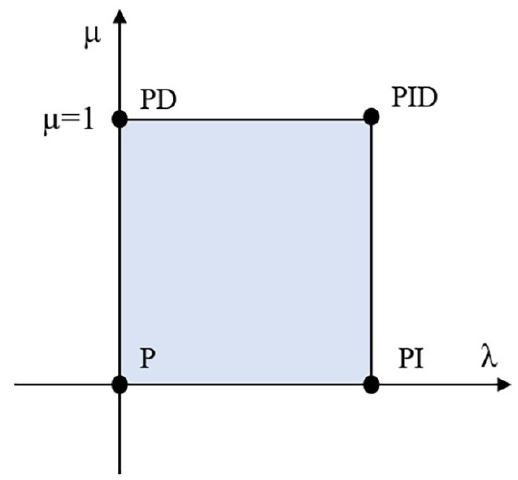
Figure 4. Types of controllers according to λ and µ .